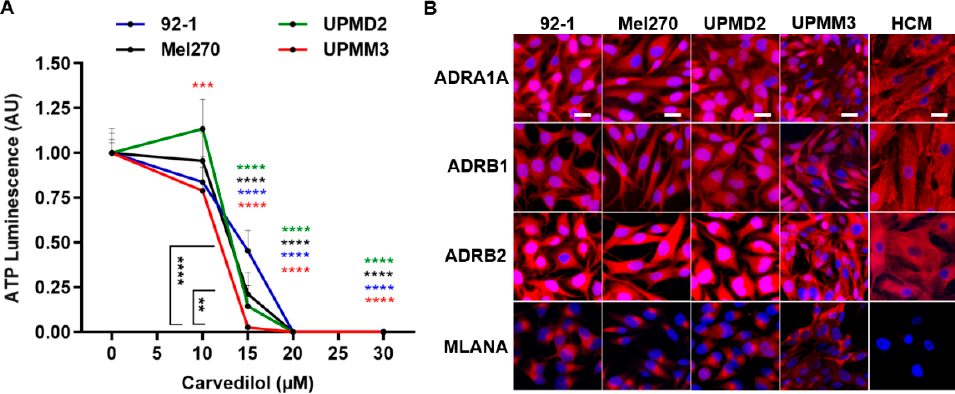
Figure 7. Effects of carvedilol on various uveal melanoma cell lines and the expression of adrenergic receptors. ( A ) Uveal melanoma cell cultures were treated with carvedilol at the indicated concentration for 7 days. Cell viability was assayed with an ATP luminescence assay. The ATP luminescence of the treated cells was normalized to the ATP luminescence of the control cells (0 µM carvedilol) and is given in arbitrary units (AU). Representative results from 3 independent experiments are shown. The means ± SD of n = 8 cell cultures for each condition are shown. Statistical analysis was performed with two-way ANOVA and Tukey’s multiple comparisons test, and the significance levels of the treated cells in relation to the control cells are indicated in color. Significance levels are indicated at ** p < 0.01, *** p < 0.001, and **** p < 0.0001. ( B ) Uveal melanoma cell lines or human cardiomyocytes (HCM) grown on coverslips and adrenergic receptors α 1 (ADRA1A), ß1 (ADRB1) and ß2 (ADRB2) or melanoma marker MLANA were detected by immunofluorescence (displayed in red colour). Human cardiomyocytes served as positive controls for the expression of adrenergic receptors. Cell nuclei were counterstained with DAPI (displayed in blue). Merged images are shown, and the scale bars indicate 20 µm.